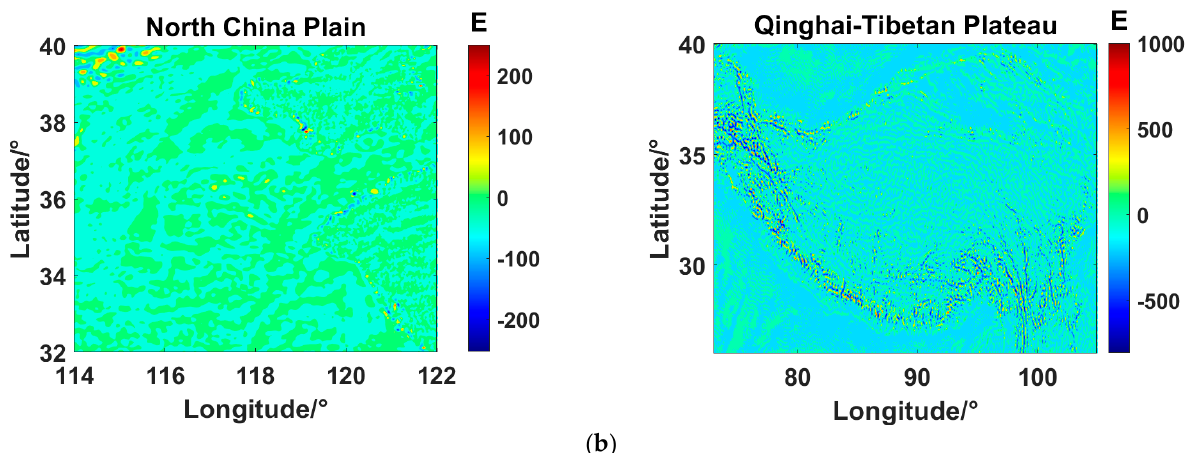
Figure 2. Gravity field data from the UCSD: ( a ) gravity; ( b ) gravity gradient. Table 1. Statistics of the UCSD gravity data. Unit: mGal.